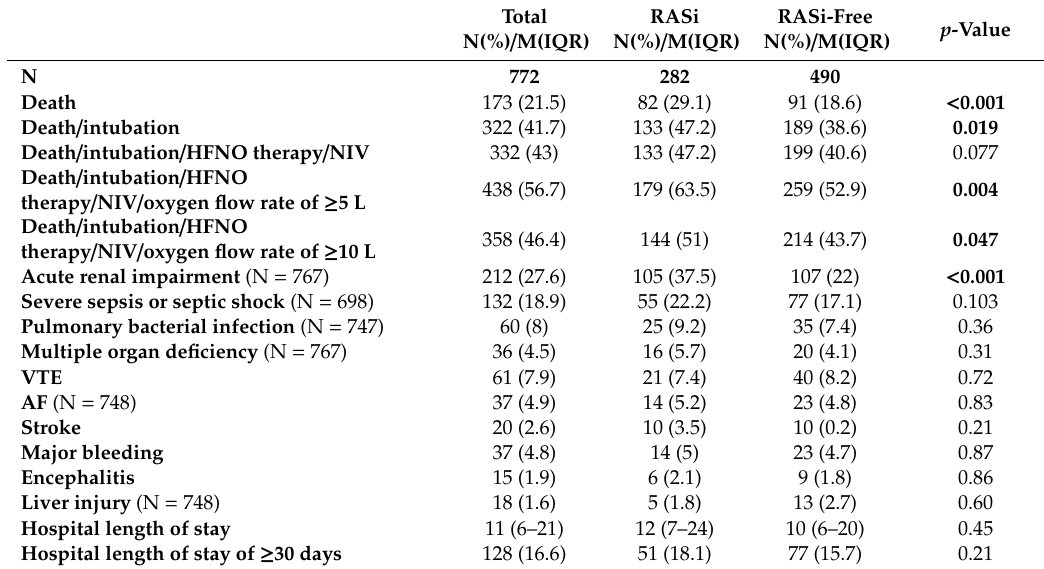
Table 2. In-hospital outcomes according to RASi treatment at